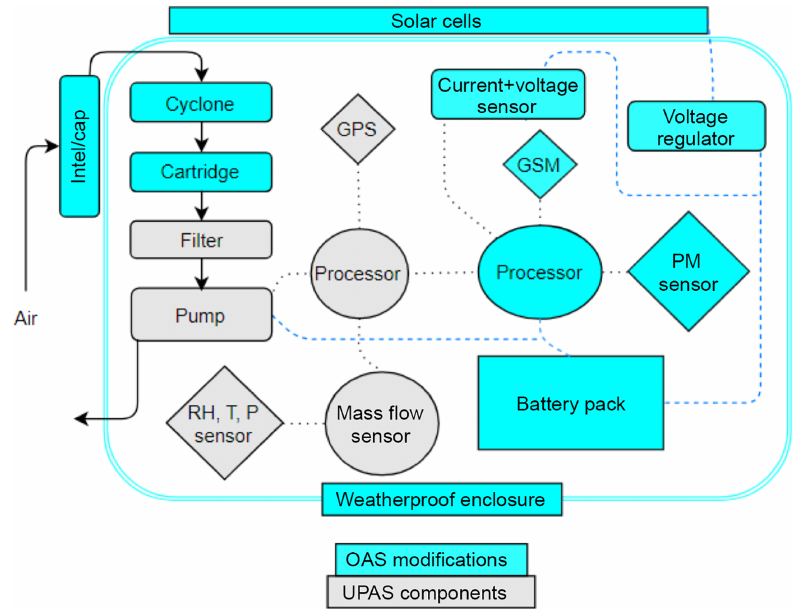
Figure 2. Block diagram of UPAS technology with component integration to form the OAS: GSM (Global System for Mobile Communica- tions), PM (particulate matter), GPS (Global Positioning System).